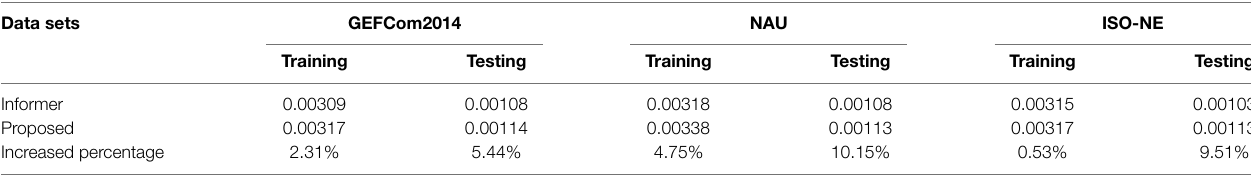
TABLE 8 | Running time of the proposed model on the three data sets